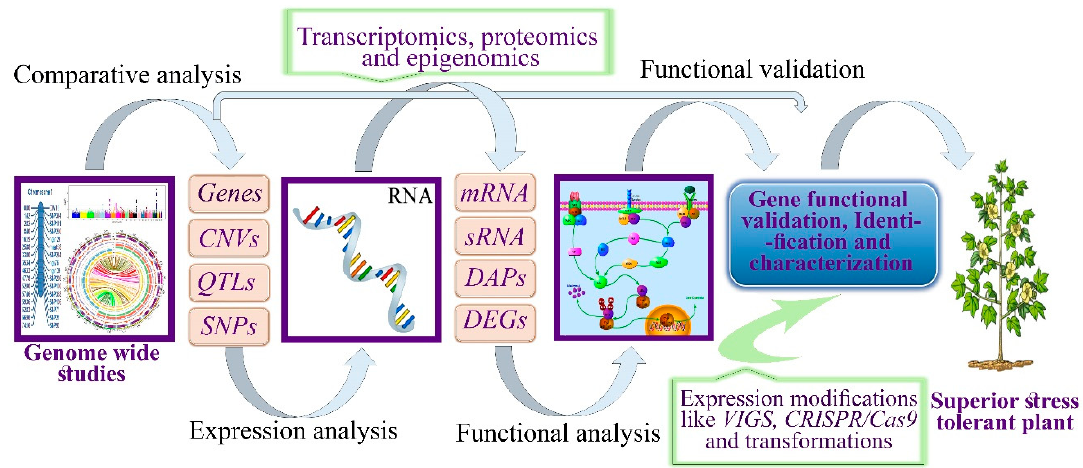
Figure 5. Schematic flow of research processes from genome-wide studies to functional validation, characterization, and identification of drought stress-responsive genes in plants. QTL, quantitative trait loci, CNV, copy number variation, SNP, single nucleotide polymorphism, mRNA, messenger RNA, SRNA, small RNA, DAP, differential abundant proteins, and DEG, differential expressed genes.